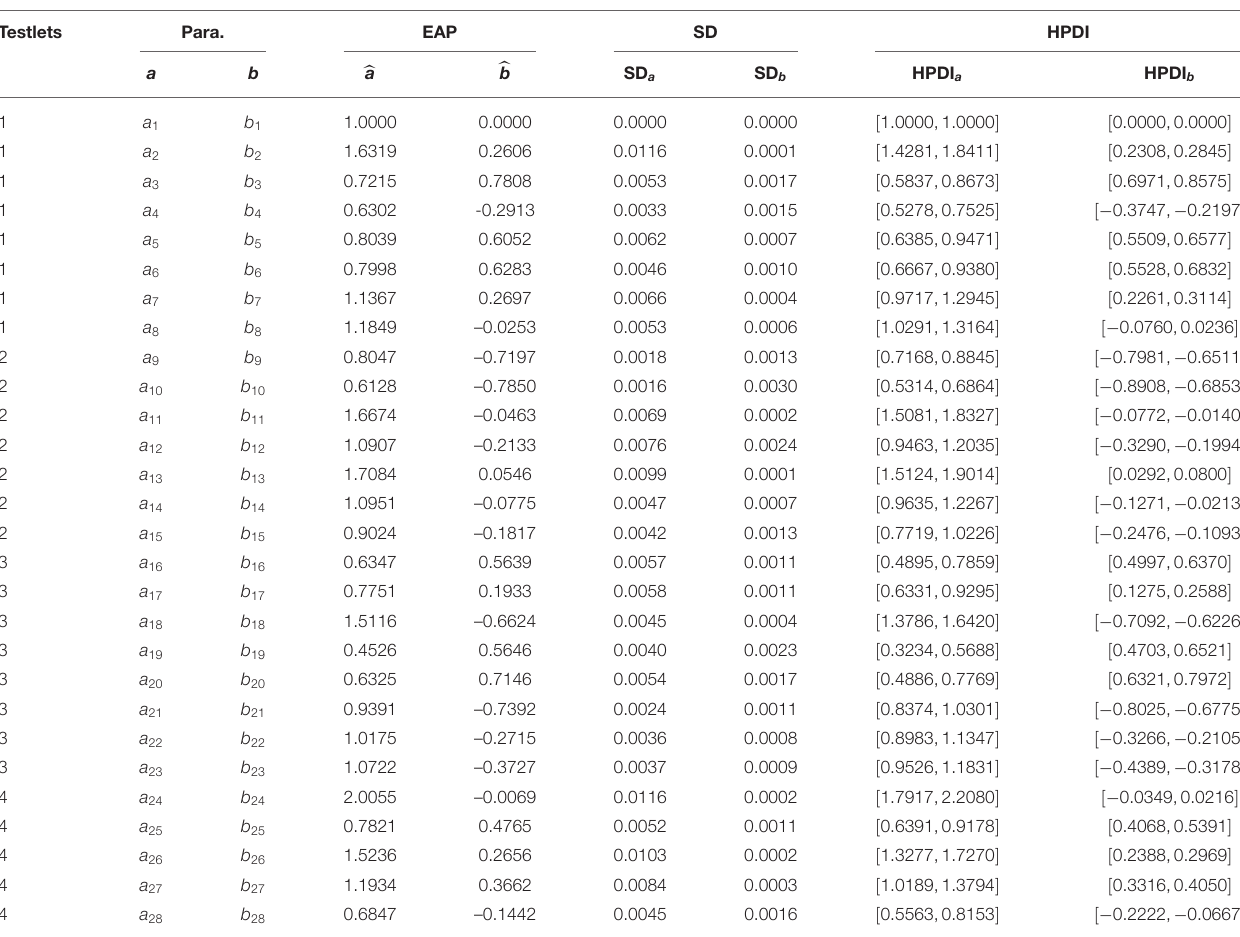
TABLE 8 | The estimation results of item parameter for the real data.